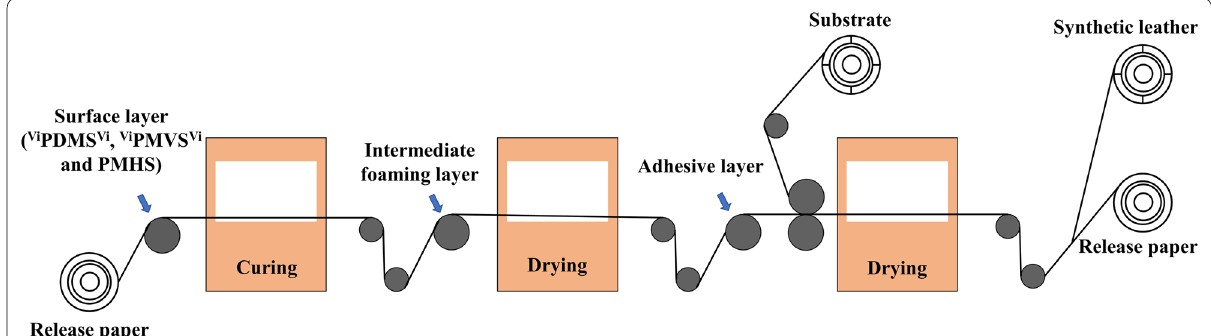
Fig. 2 Schematic diagram of PDMS synthetic leather manufacturing process